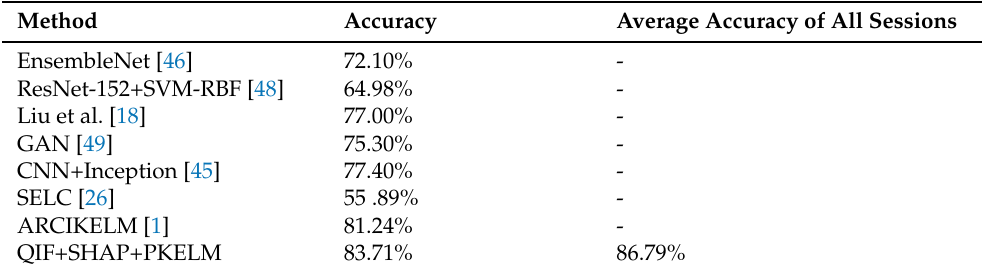
Table 8. Summary of research using deep feature extraction and fine-tuning methods to classify the Food101 dataset.